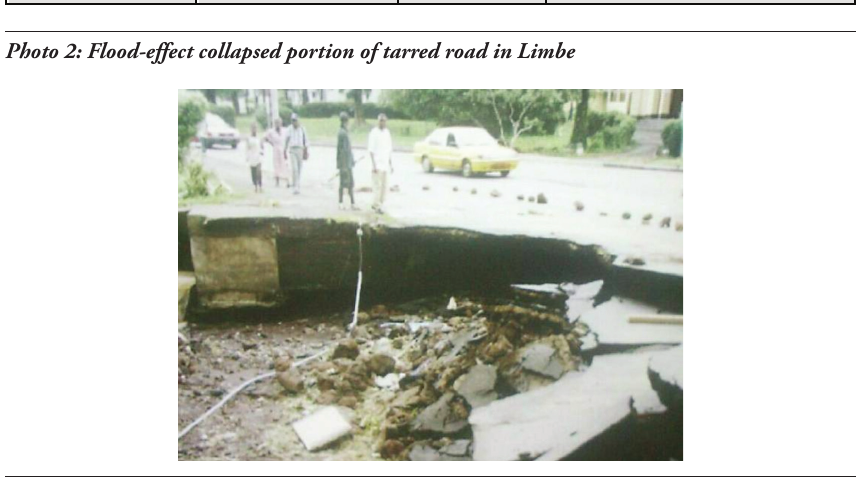
Photo 3: Flood-effect destroy streams nearby houses in Limbe